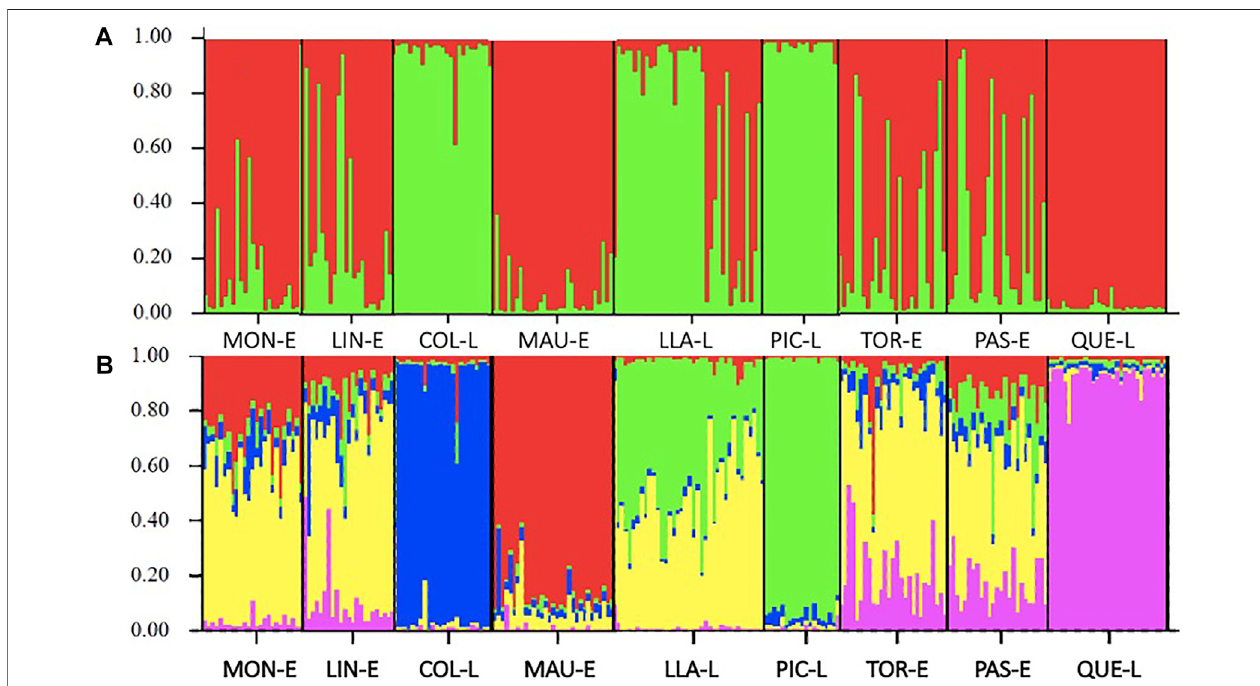
FIGURE3 | Genetic differentiation between locations, assessed byBayesiananalysis: (A) Diagram of the estimated population structure ofGalaxiasmaculatus for theninelocationssampledwithK=2,thecoloursrepresentthegeneticgroups; (B) Diagramofpopulationstructure withK=5.Thenameofthelocalitiesisobservedon thelowerhorizontalaxis:MON-E:MonculEstuary;LIN-E:LingueEstuary;COL-L:ColicoLake;MAU-E:MaullínEstuary;LLA-L:LlanquihueLake;PIC-LPichilagunaLake; TOR-E: Tortel Estuary; PAS-E: Pascua Estuary and QUE-L Quetru